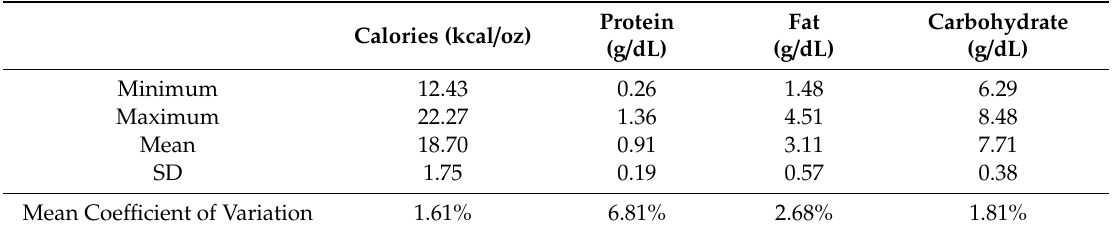
Table 2. Near-infrared (NIR) macronutrient analysis of donor breast milk (DBM) samples ( n = 96).